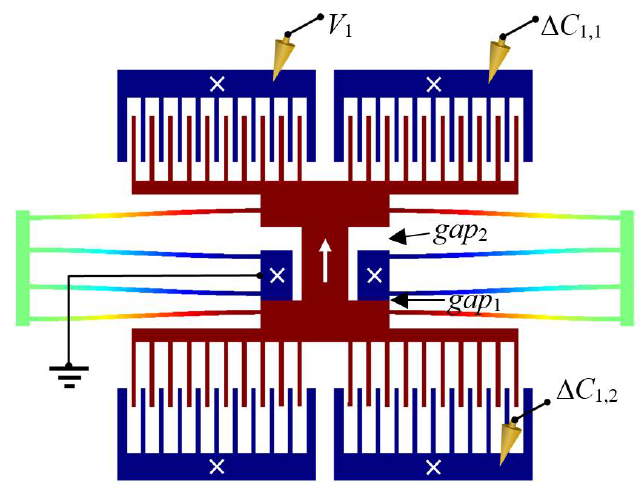
Figure 1. Simulated illustration of an electrically-probed calibration of a MEMS device. One probe applies a voltage V 1 to close one of two asymmetric gaps, while the differential capacitance to traverse gap 1 is measured. Many other aspects of the design, such as the type flexures, are irrelevant. By closing the gaps and resonating the structure, the device’s mass, damping, stiffness, and state can be accurately and precisely measured after packaging and long-term dormancy. This is, it is capable of self-calibration.